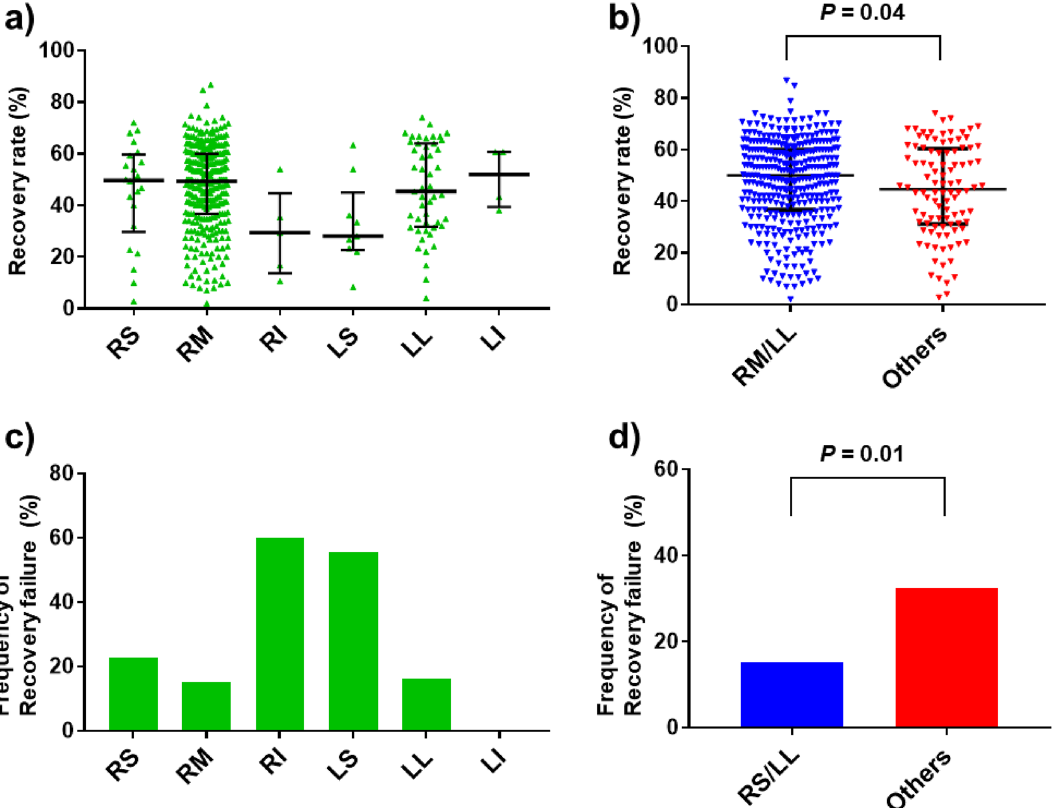
Figure 2. BALF recovery rates and recovery failure frequency in the derivation cohort. ( a ) The median BALF recovery rates (interquartile ranges) from RS, RM, RI, LS, LL, and LI were 49.7% (29.7–59.7), 49.3% (36.7–60.0), 29.7% (13.7–44.7), 28.0% (22.7–45.0), 45.3% (32.7–64.0), and 51.9% (39.3–60.7), respectively. ( b ) The median BALF recovery rate in the RM/LL group was significantly higher than those in the others group (49.3% vs. 43.3%, respectively, P = 0.04). ( c ) The BALF recovery failure frequency in RS, RM, RI, LS, LL, and LI were 22.7%, 15.1%, 60.0%, 55.6%, 16.3%, and 0%, respectively. ( d ) The BALF recovery failure frequency in the RM/ LL group was significantly lower than those in the others group (15.2% vs. 32.5%, respectively, P = 0.01). BALF bronchoalveolar lavage fluid, RS right superior lobe, RM right middle lobe, RI right inferior lobe, LS left superior lobe other than lingual, LL left lingual, LI left inferior lobe.